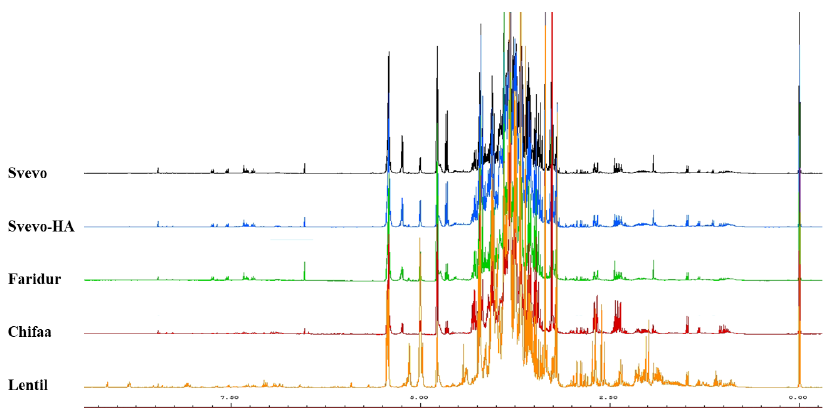
Figure A6. 1 H NMR spectra of aqueous extracts obtained using a 600 MHz spectrometer equipped with a cryoprobe.